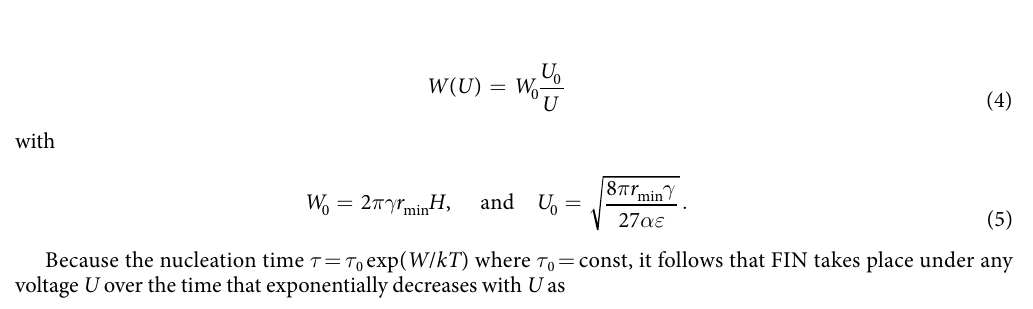
Figure 2. The free energies of a conductive embryo vs. its height in the electric fields of three different strengths, corresponding (from right to left) to the unstable, metastable, and thermodynamically stable embryos. The initial state of the system corresponds to h ≈ 0 (to the accuracy of thermal energy fluctuation ~ kT ). W is the nucleation barrier height, W ms is the barrier determining the lifetime of a metastable embryo. The inset diagram illustrates how the transition creates a state (in TS) that is unstable upon the field